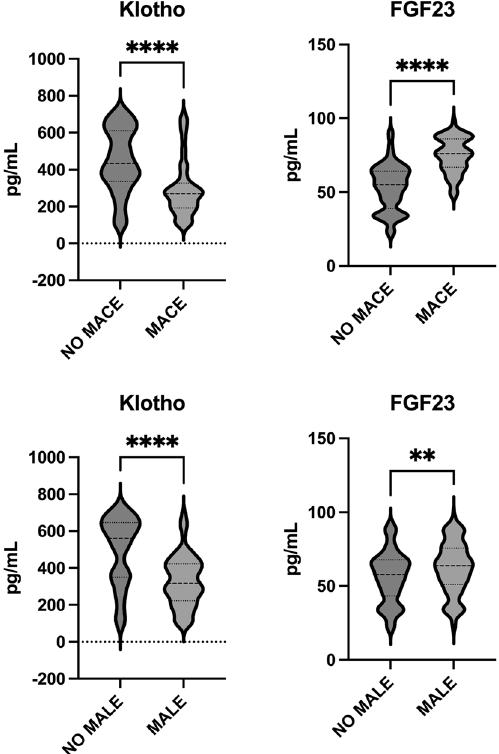
Figure 1. Klotho, and FGF23 levels according to MACE and MALE outcomes. On the violin plots, shape shows the distribution, central line represents the median, upper line represents the upper interquartile range (IQR) and the lower line represents the lower IQR. **** = p < 0.0001, ** = p <